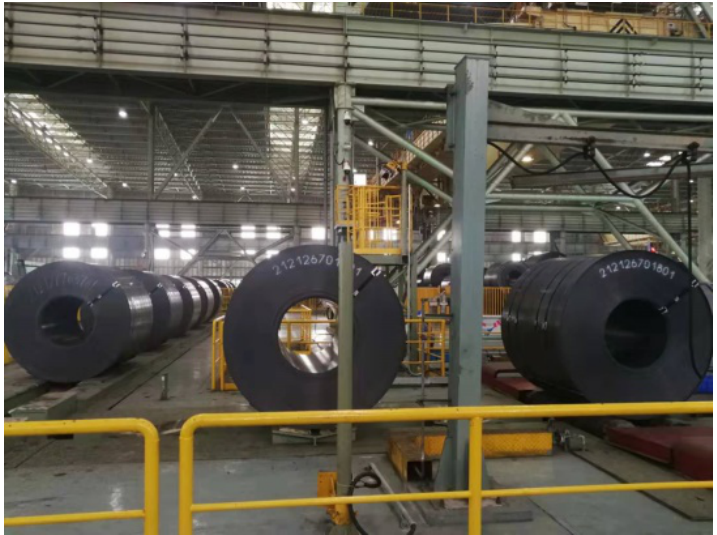
Figure 2. The finished steel